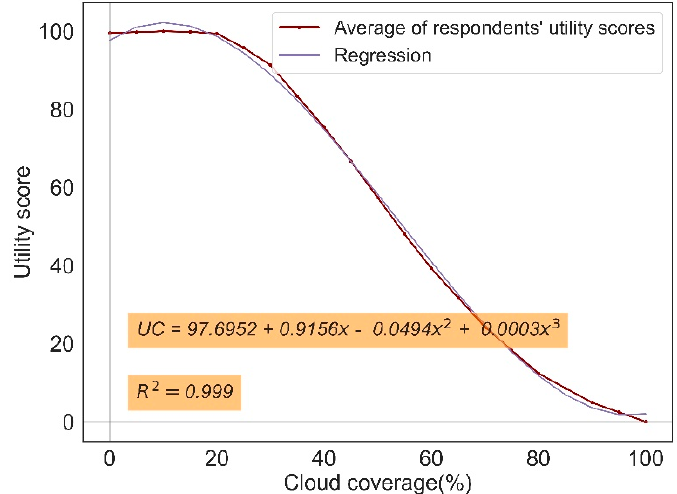
Figure 12. Empirical utility function for cloudiness in urban tourism.